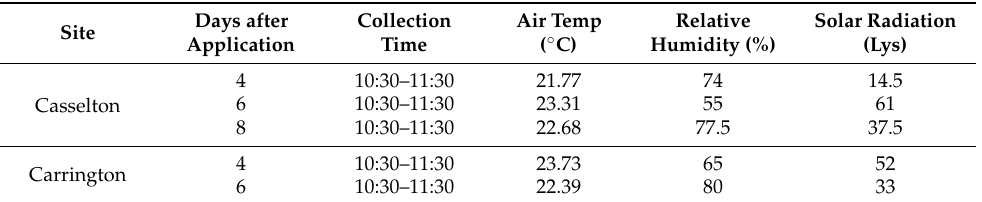
Table 1. Weather conditions during data